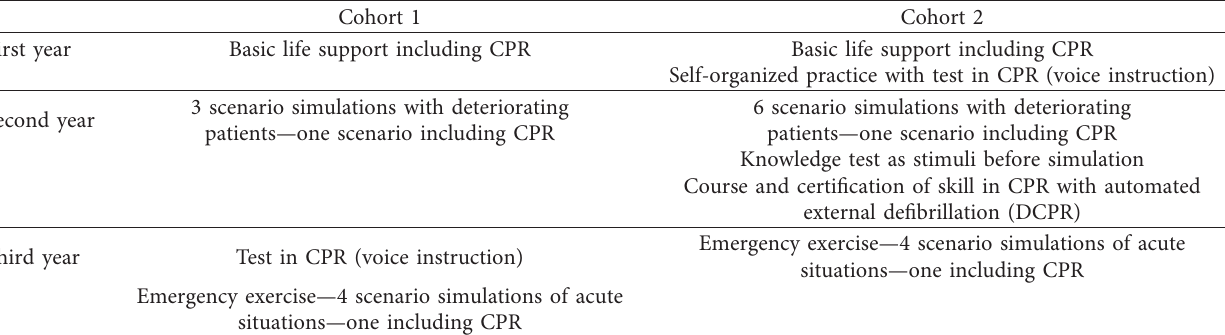
Table 1: Structure of basic life support education including